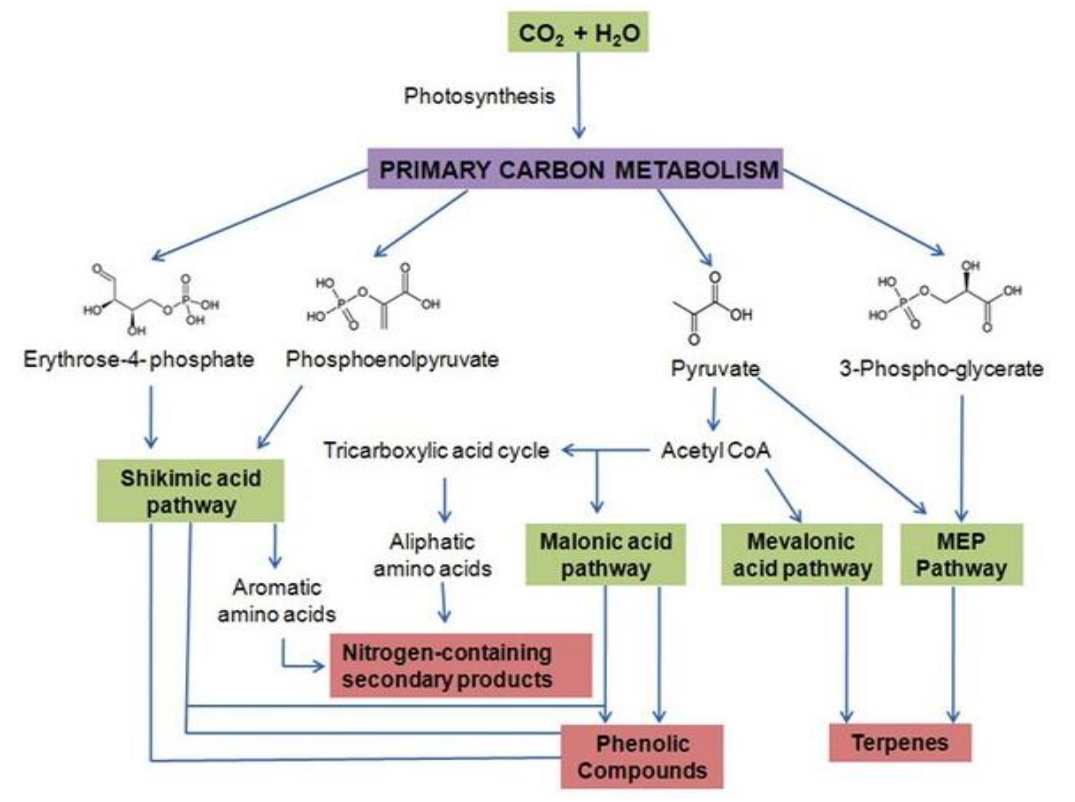
Figure 2. Layout of drug discovery process: from nature to market.